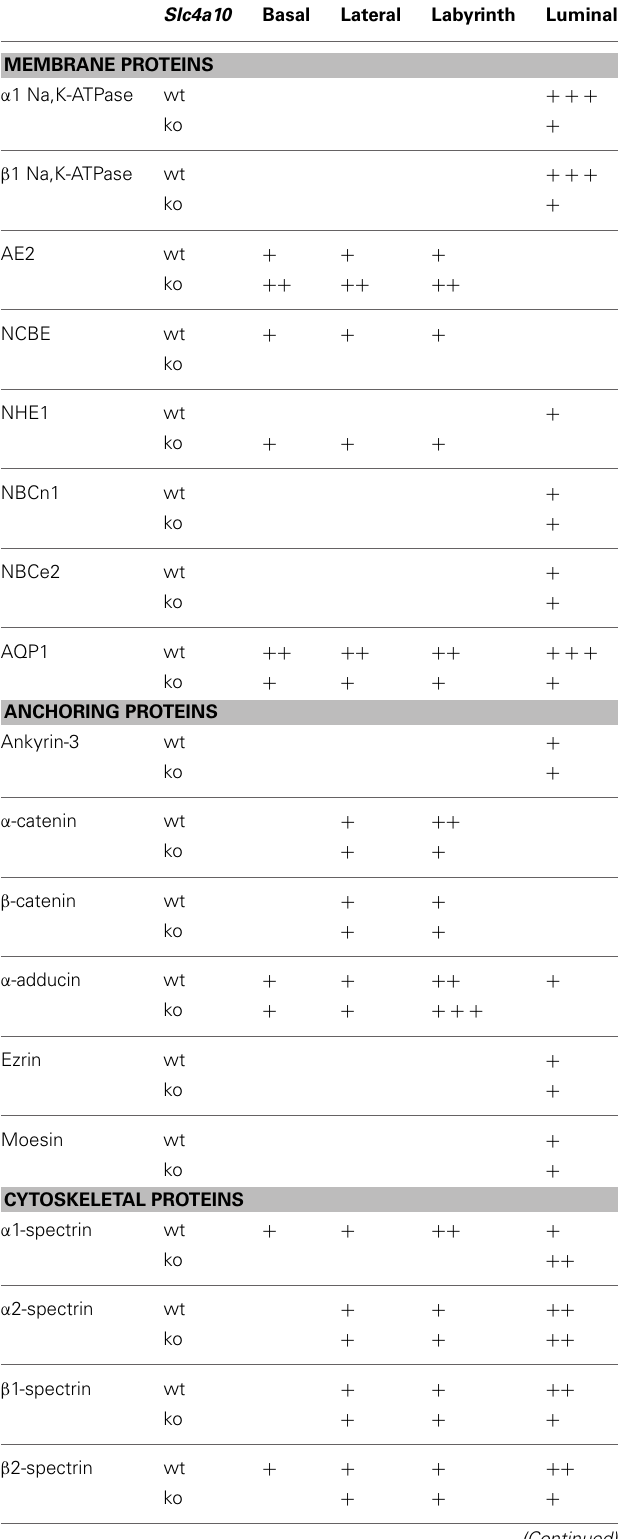
Table 2 | Summary of data presented for CPE in the current and two previous studies (Damkier et al., 2009; Damkier and Praetorius, 2012). Slc4a10